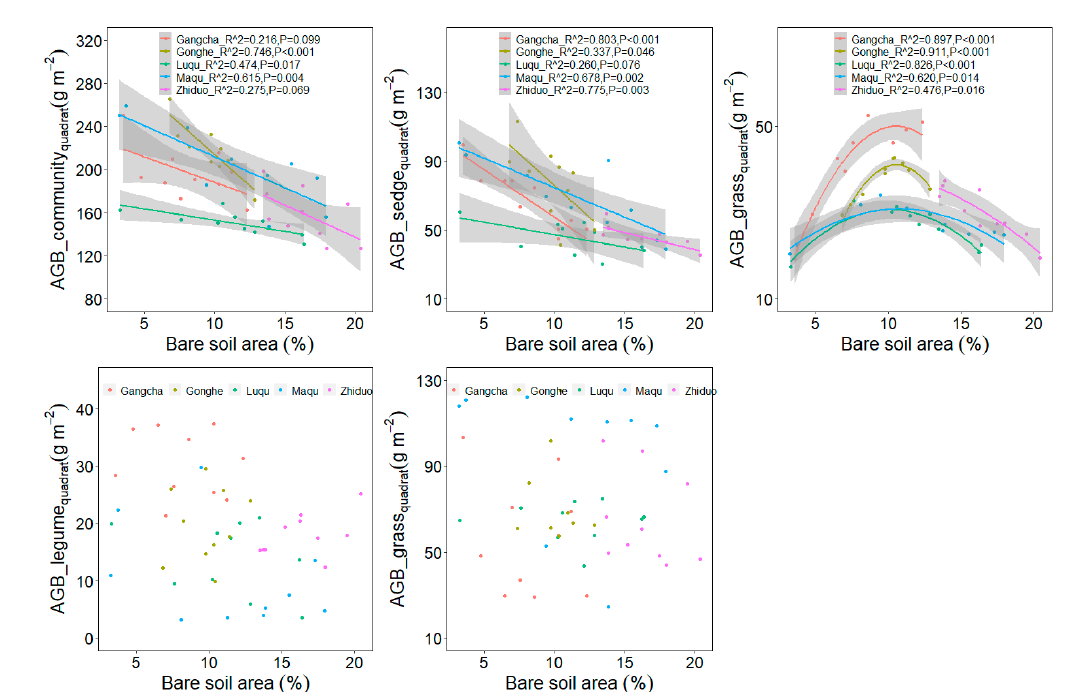
Figure 5. Relationship between plant aboveground biomass at quadrat scale and the bare soil area (%) in each site based on a LM. AGB, aboveground biomass.